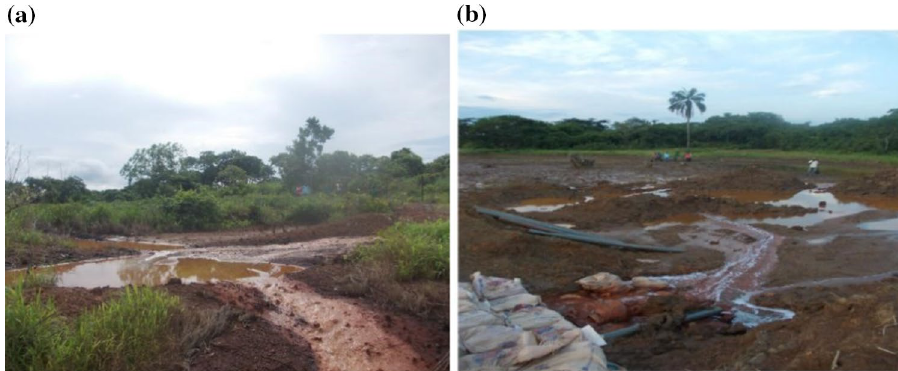
Fig. 1 a Effluent discharge from Mine at Alibrauhu which flow into surface water bodies. b Mine waste discharge into Ameka surface